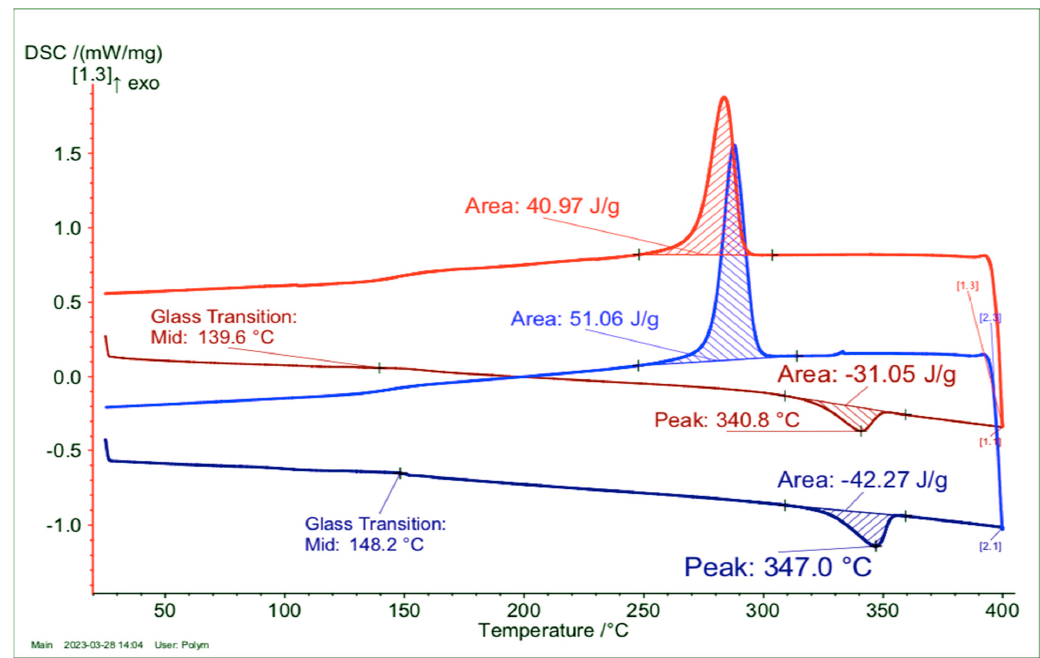
Figure 1. DSC curves for PAEK and PAEK/CF filaments at a heating rate of 5 K/min are shown in red and blue, respectively, followed by cooling curves at 20 K/min. The area under the melting curve can be used to calculate the degree of crystallinity.